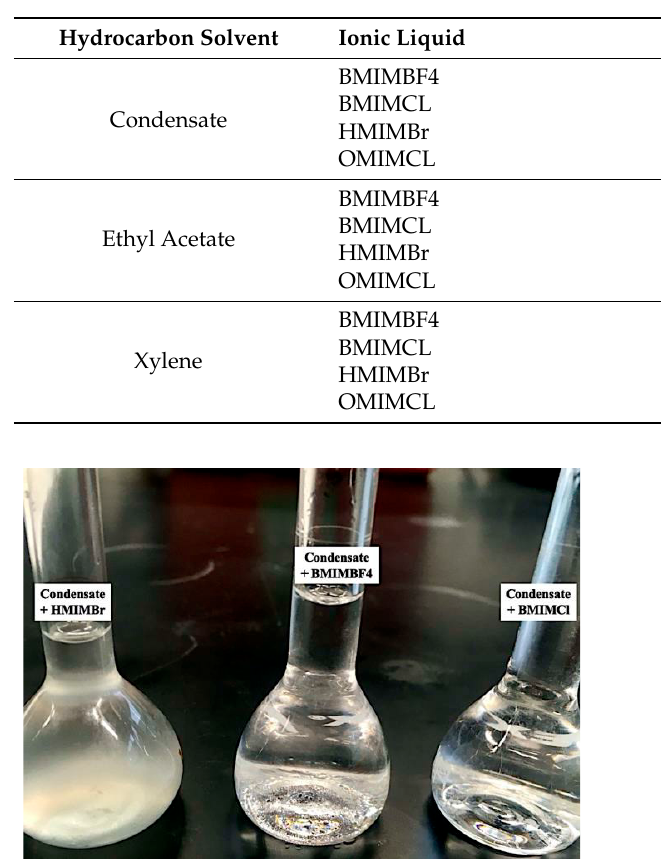
Table 1. Miscibility of Ionic Liquid in hydrocarbon solvents.